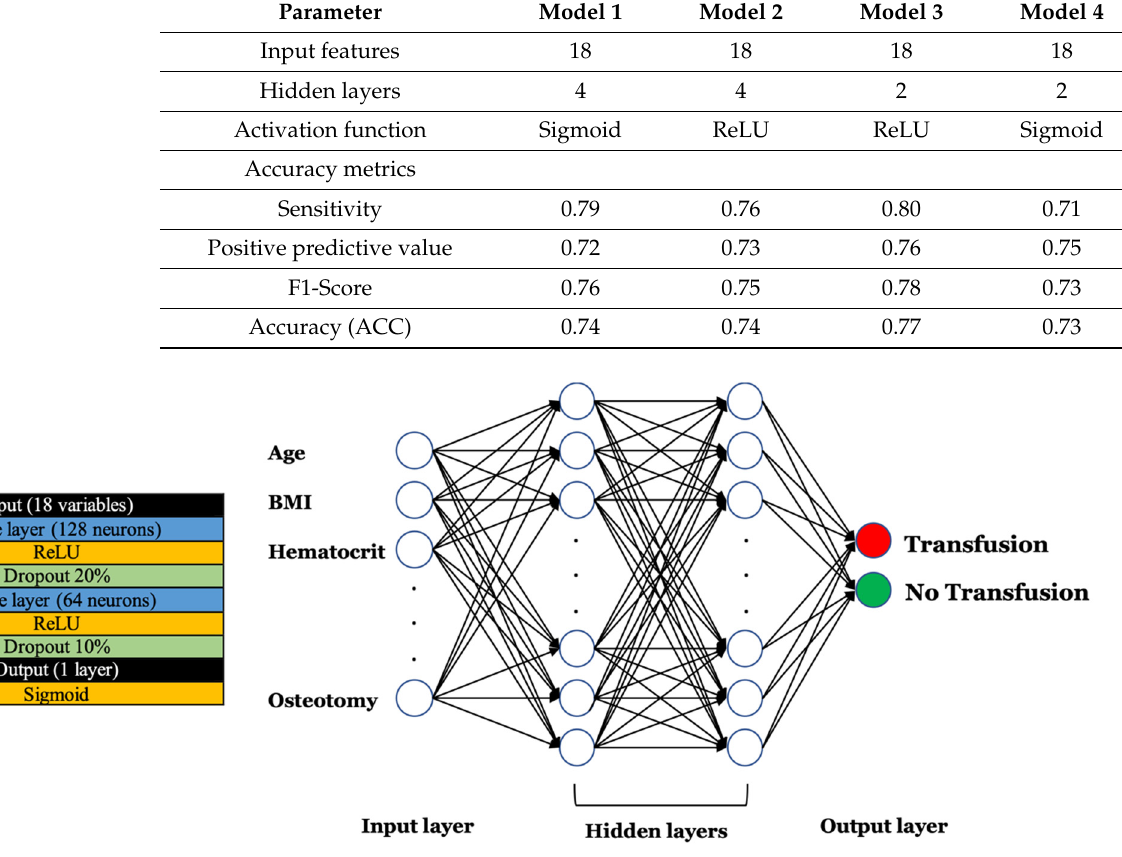
Figure 1. Artificial Neural Network architecture.